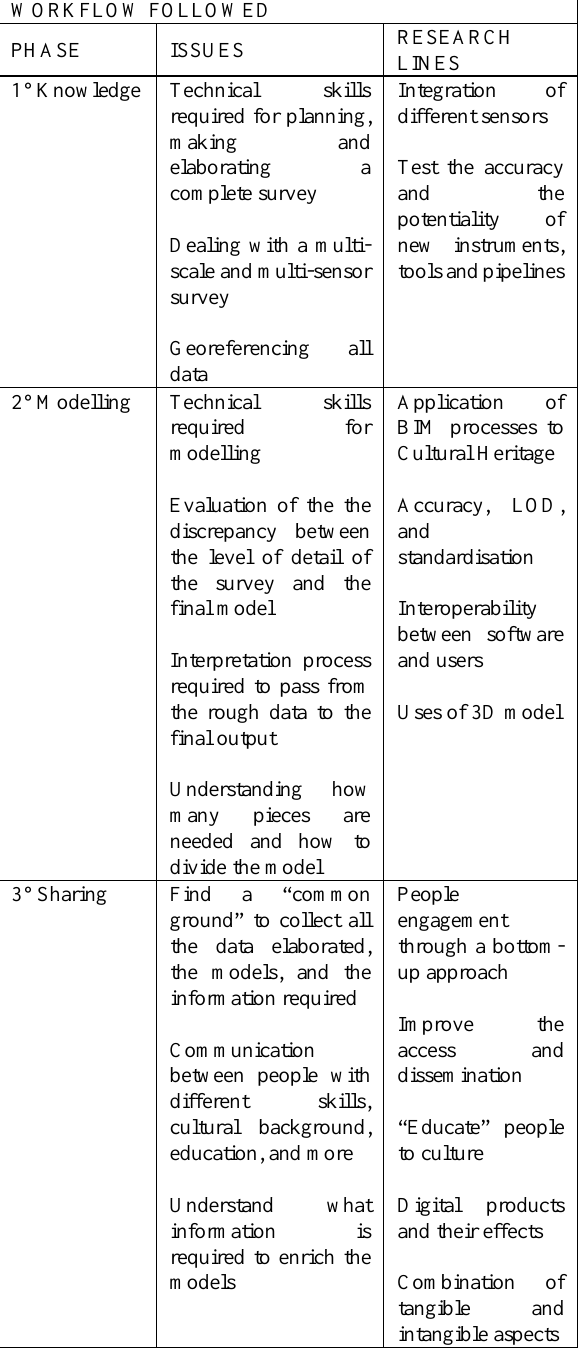
Table 1: Main issues and research lines of the used workflow